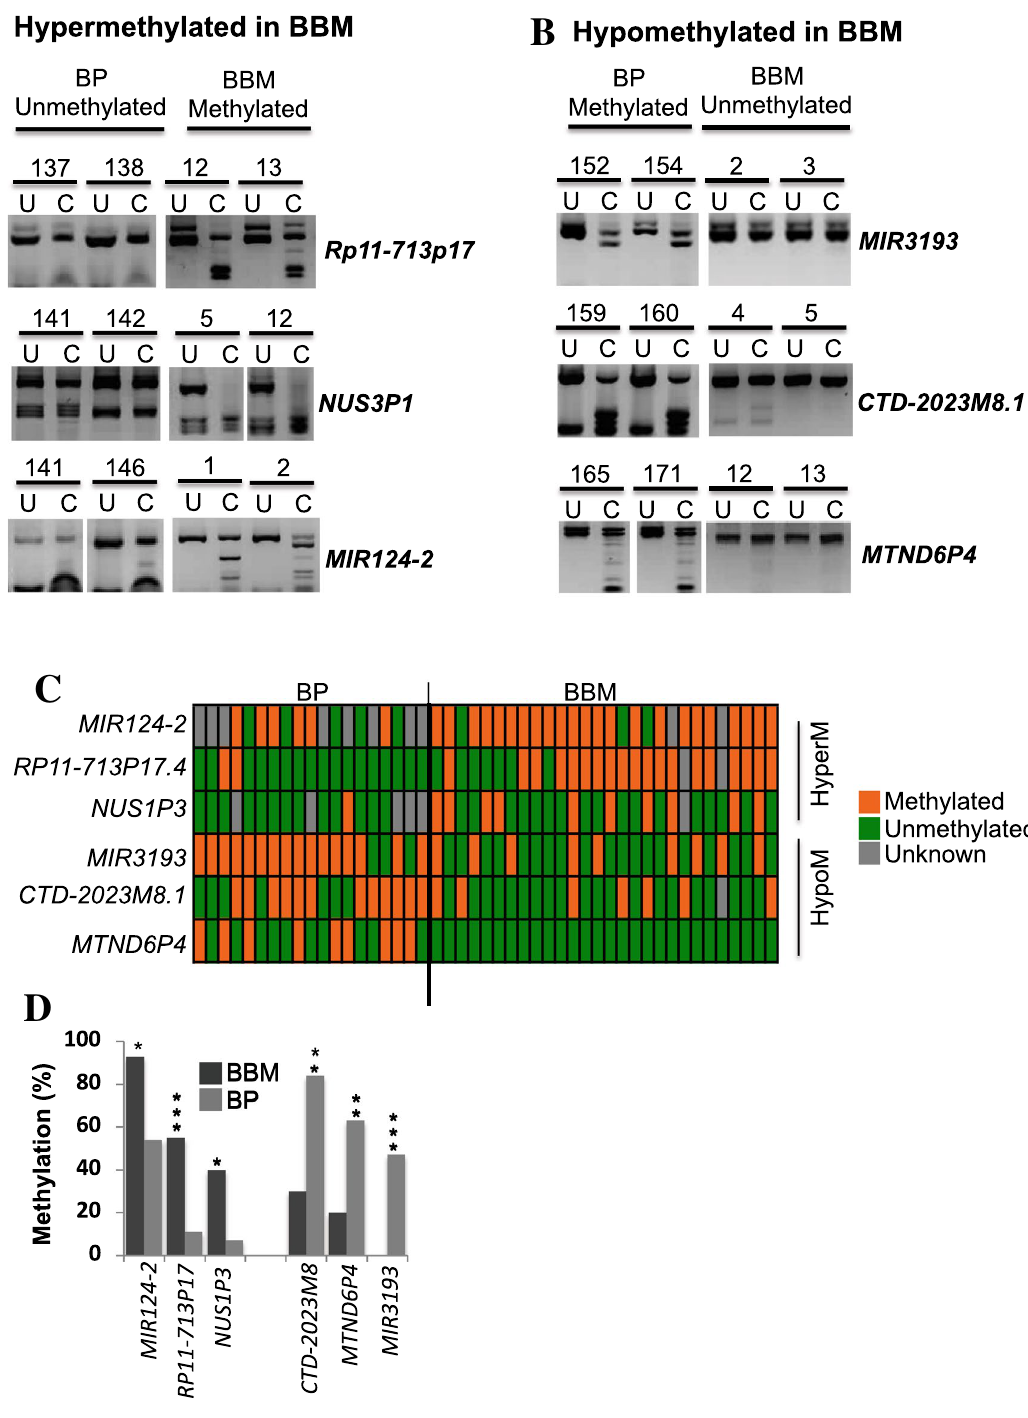
Figure 2. Representative examples of experimental validation of methylation status of candidate genes hypermethylated in breast to brain metastases (BBM) in a cohort of non-metastatic primary breast tumours (BP) (n = 20) and BBM (n = 30) using Combined Bisulphite and Restriction Analyses (CoBRA). ( A ) The two genes RP11 -713P17.4 and NUS1P3 are infrequently methylated in BP and frequently methylated in BBM (In addition, MIR124-2 methylation is enriched in BBM compared to primary breast tumours). In contrast, ( B ) MIR3193, CTD-2023M8, and MTND6P are frequently methylated in BP and infrequently methylated (hypomethylated) in BBM. ( C ) An overview of the methylation status of genes that are hypermethylated or hypomethylated in BBM in all BBM and BP samples analysed by CoBRA (each box represents a tumour). ( D ) Summary of methylation status of genes in primary and metastatic brain tumours, *: Indicates statistical significant difference between primary and BBM tumours. BBM: Breast to Brain Metastases, BP: Primary breast tumours, U: Uncut/control sample, C: cut by restriction enzyme, , HyperM: hypermethylated in BBM, HypoM: Hypomethylated in